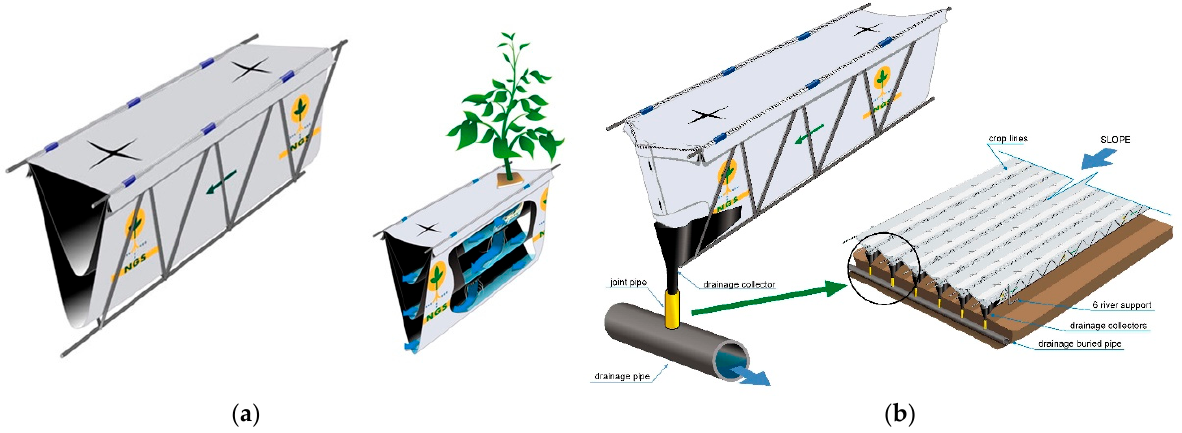
Figure 2. ( a ): View of the multi-channel film that is used to create separate channels for the flow of the hydroponic nutrient solution (HNS) and root development. Two channels are created for short crop cycle species, such as lettuce ( left ), while three channels are created for long cycle crop species, such as tomato, to allow root growth expansion ( right ). ( b ): View of the NGS ® drainage collection system (courtesy of www.ngsystem.com (accessed on 5 September 2020)).